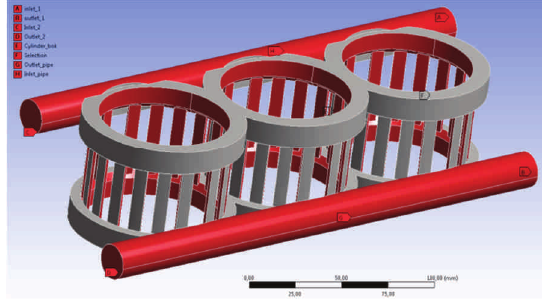
Fig. 5. The geometry model of the jacket in geometry module in Ansys